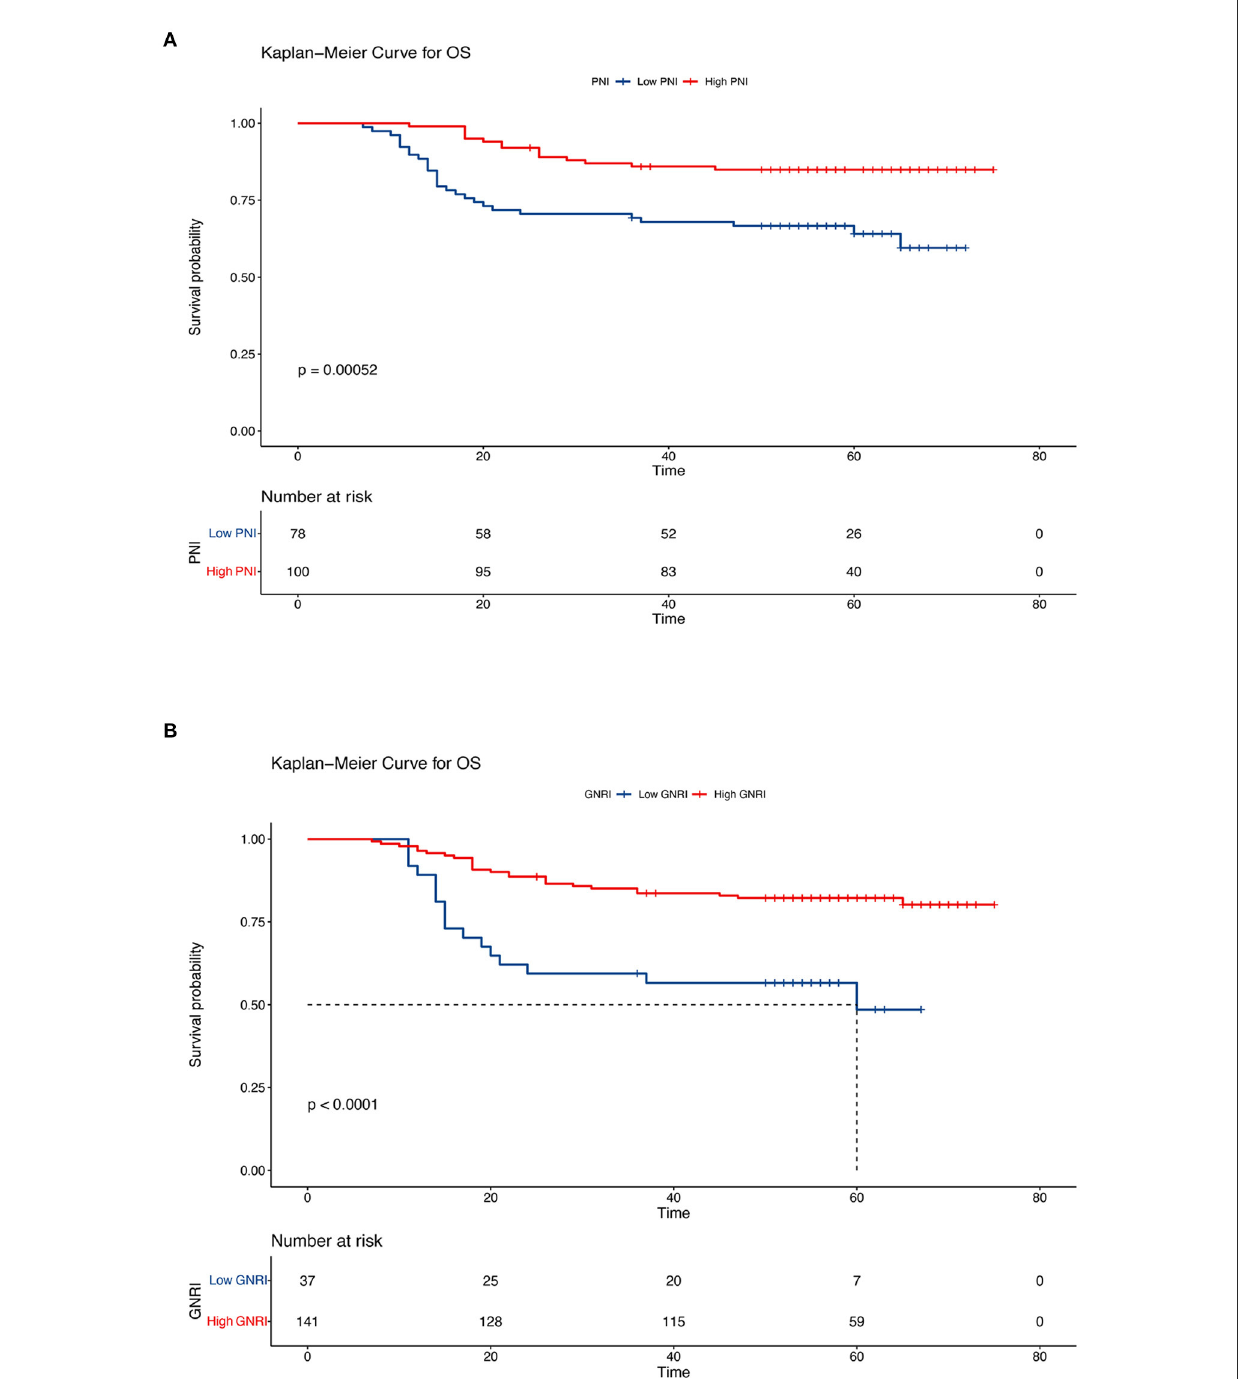
FIGURE3 Kaplan–Meier curves of overall survival according to the nutritional indicators. (A) Low prognostic nutritional index (PNI) vs. high PNI (low PNI: ≤ 48.3, high PNI: > 48.3) and (B) low geriatric nutritional risk index (GNRI) vs. high GNRI (low GNRI: ≤ 97.04, high GNRI: > 97.04). The Kaplan–Meier method was used to calculate the survival rate, and the log-rank test was used to compare survival distributions between the